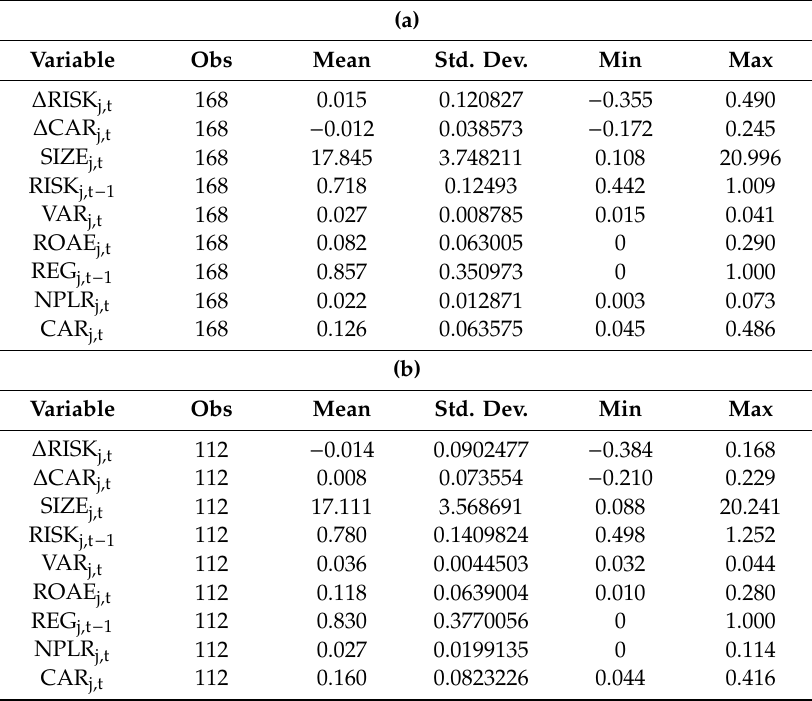
Table 2. ( a ) Summary statistics of the dataset from 2013 to 2018 (after fully a ff ected by Basel Accords). ( b ) Summary statistics of the dataset from 2009 to 2012 (before fully a ff ected by Basel